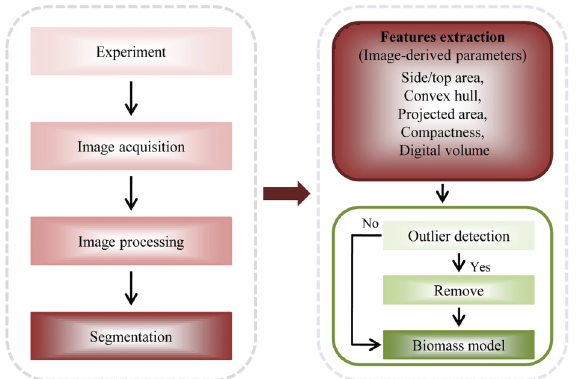
Figure 1: Workflow for the image-derived biomass model construction. High-throughput imaging data from automated phenotyping system require image storage and image processing (Left). Then expected features/phenotypic traits need to be extracted from the segmented images. Eliminating outliers in the phenotypic data is another key pre-processing step before model construction, and then need to perform the biomass model for estimating image-derived biomass